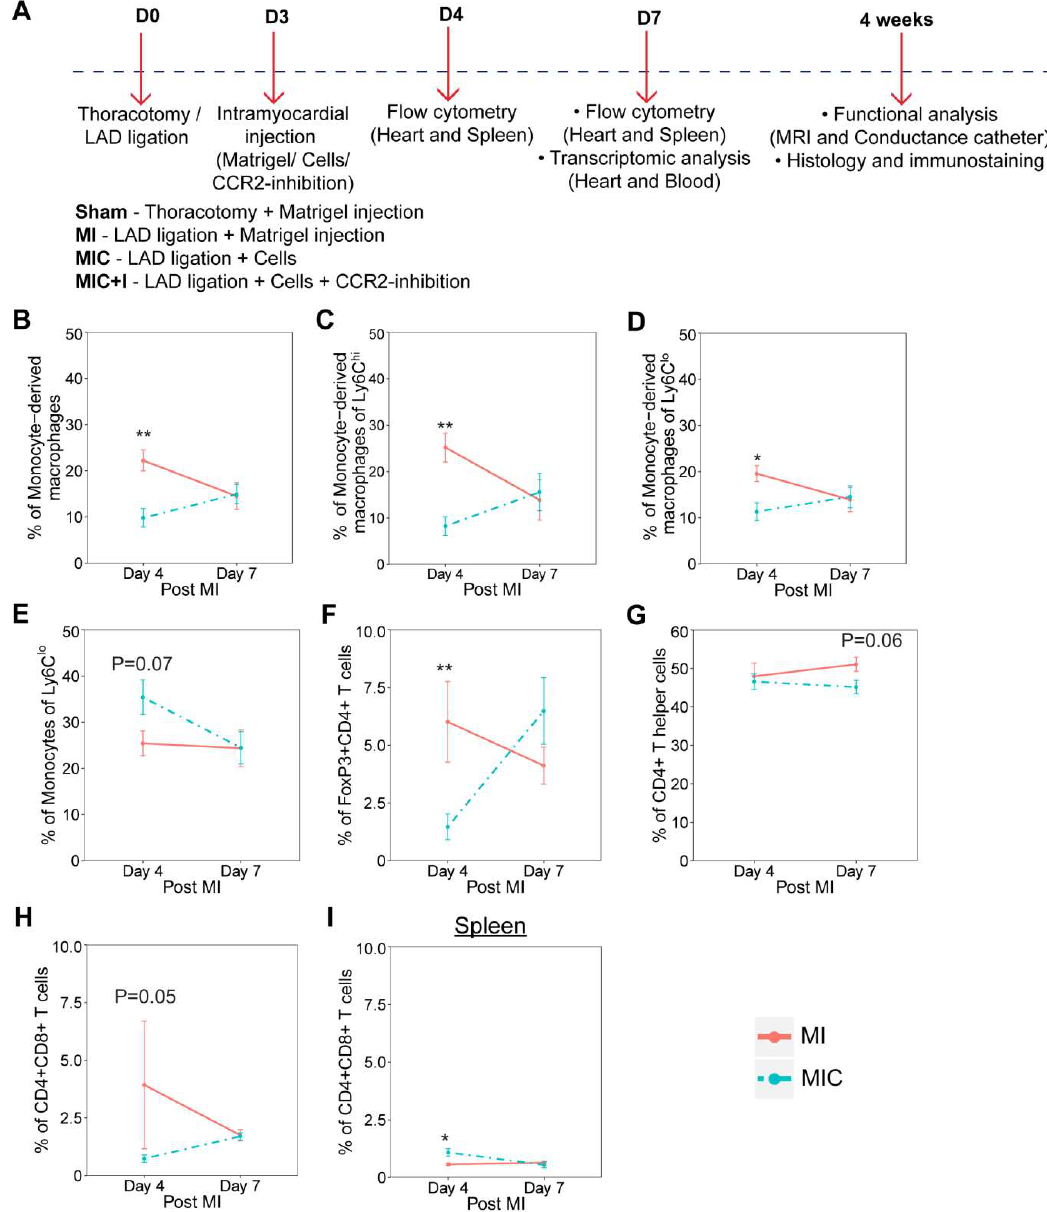
Figure 2. Cardiomyocyte transplantation alters the immune response in the heart after myocardial infarction (MI). ( A ) Experimental setup. ( B – I ) Flow cytometric analysis of the various immune cell populations in the heart ( B – H ) and spleen ( I ) of C57BL/6J mice four and seven days following MI and cardiomyocyte transplantation (MIC). The various cell populations were identified based on the strategy presented in Figure 1. n = 7. Values are represented as the mean ± SEM. Significance was calculated using the Mann–Whitney test. * p < 0.05, ** p < 0.01. 3.2. Intramyocardial Syngeneic Cardiomyocyte Transplantation Improves Cardiac Pump Function Cardiac morphology and function were assessed four weeks after MI/thoracotomy using MRI. The pressure characteristics were also recorded after MRI using a conductance catheter. Cardiomyocyte transplantation led to a significant improvement in cardiac function as observed by the increase in LVEF (58.57% ± 2.83% vs. 47.57% ± 1.77%, p = 0.006) (Figure 3A), decreased ESV (19.17 ± 2.41 µL vs. 28 ± 1.90 µL, p = 0.017) (Figure 3B) and lowered but not significant End Diastolic